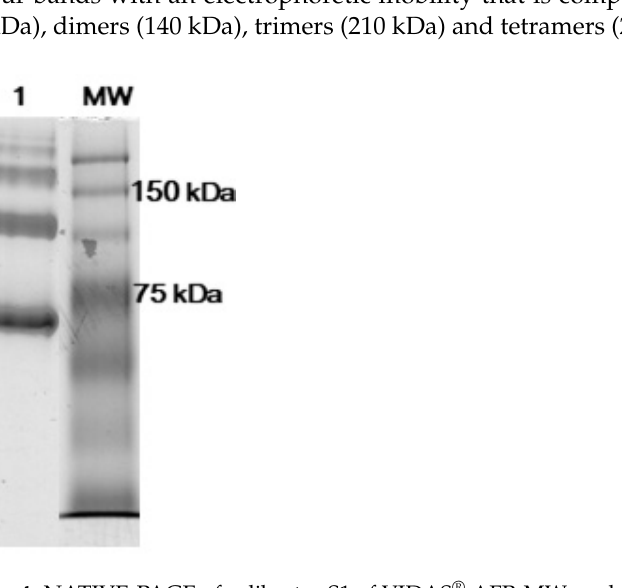
Figure 4. NATIVE-PAGE of calibrator S1 of VIDAS ® AFP. MW, molecular weights.